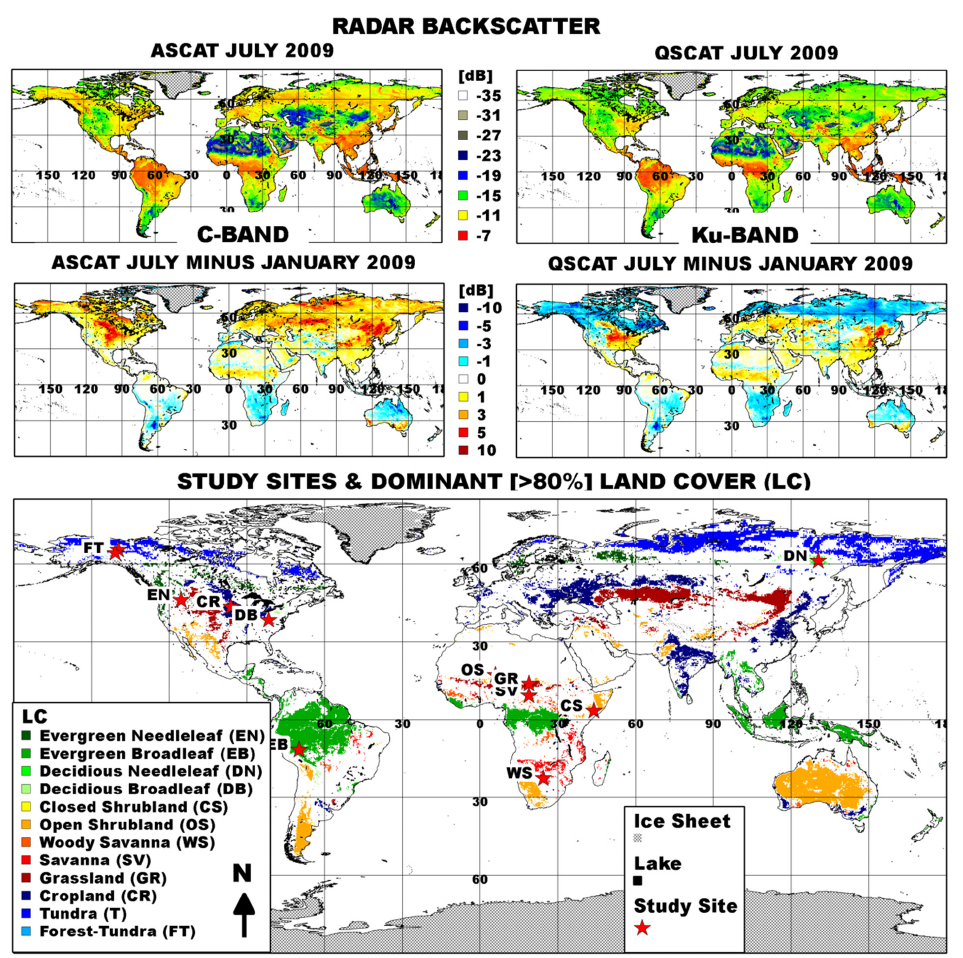
Figure 2. Global morning overpass radar backscatter from C-band Advanced Scatterometer (ASCAT) ( left ) and K u -band QuikSCAT (QSCAT) ( right ) during July ( top row ) and backscatter difference between July and January of 2009 ( middle row ). Actual figure color is a linear interpolation of the colors in the legend. Selected study sites and distribution of dominant vegetated land cover classes as obtained from MODIS LC ( bottom panel ). All maps in geographic projection. Distance covered by one degree of latitude is approximately 111-km.